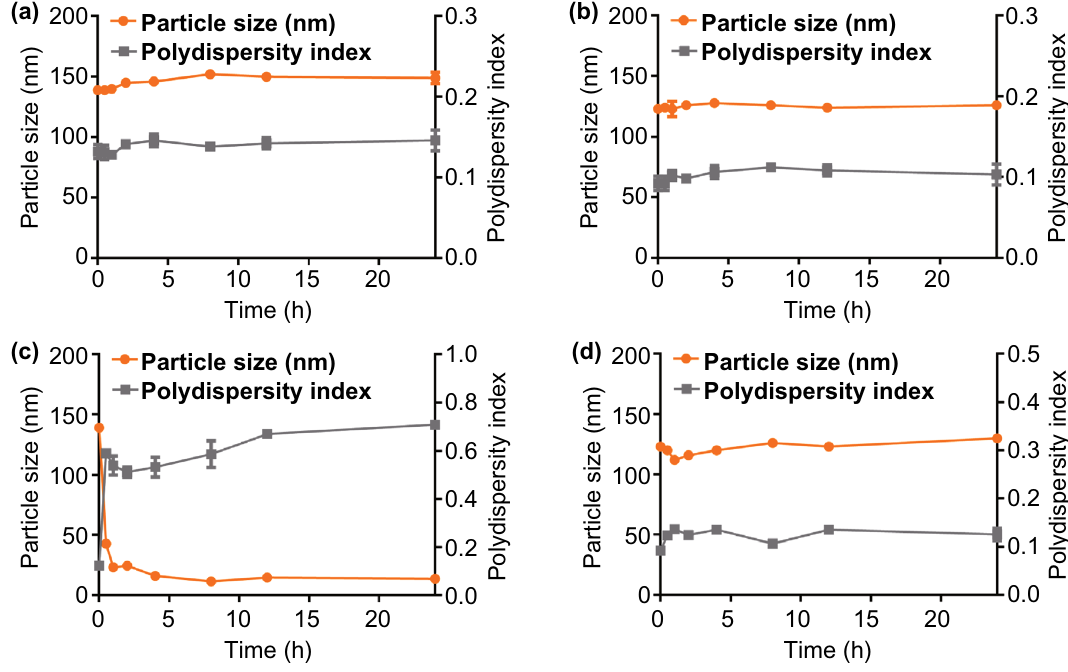
Figure 5 Stability of micellar structure against surfactants. Diameter and PDI variations of a PCS/DIC micelles and b SPCS/DIC micelles incu- bated with 0.5% Tween 80 solution. Diameter and PDI variations of c PCS/DIC micelles and d SPCS/DIC micelles incubated with 2% Tween 80 solution. Data are expressed as mean ± SD, n =